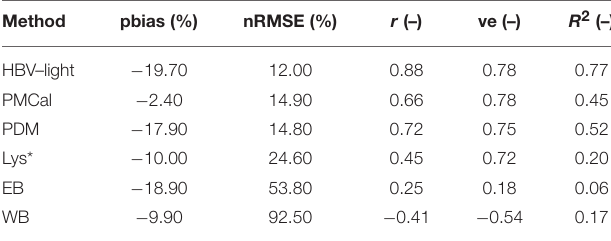
TABLE 3 | Bias percentage (pbias), normalized root mean square error (nRMSE), Pearson’s correlation coefficient ( r ), volumetric efficiency (ve), and coefficient of determination ( R 2 ) for the actual evapotranspiration estimated with the HBV-light and PDM models, the calibrated evapotranspiration equation (PMCal),